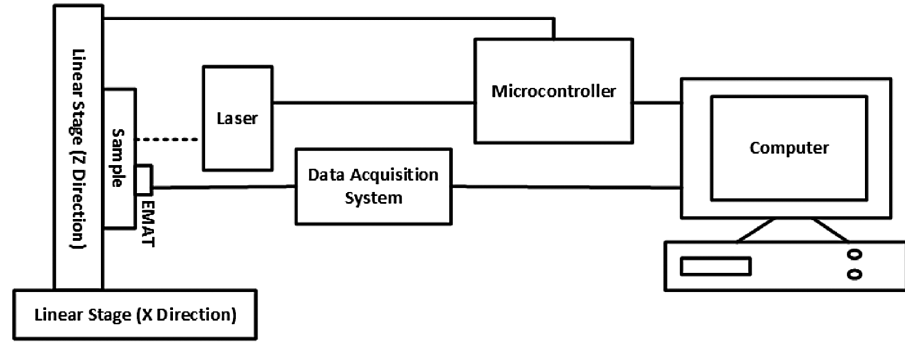
Fig. 11. Schematic diagram of experimental